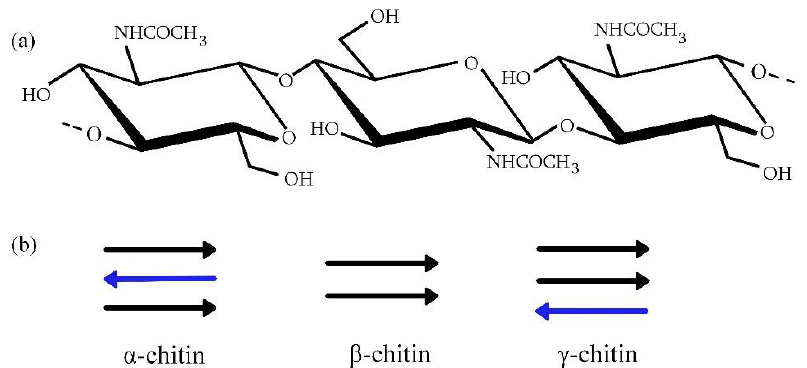
Figure 1. ( a ) Chitin structure; ( b ) Chitin forms (Arrows represent the conformation of the polymer strand; black arrows show the parallel arrangement of chains; blue arrows show antiparallel ar- rangement of chains.).